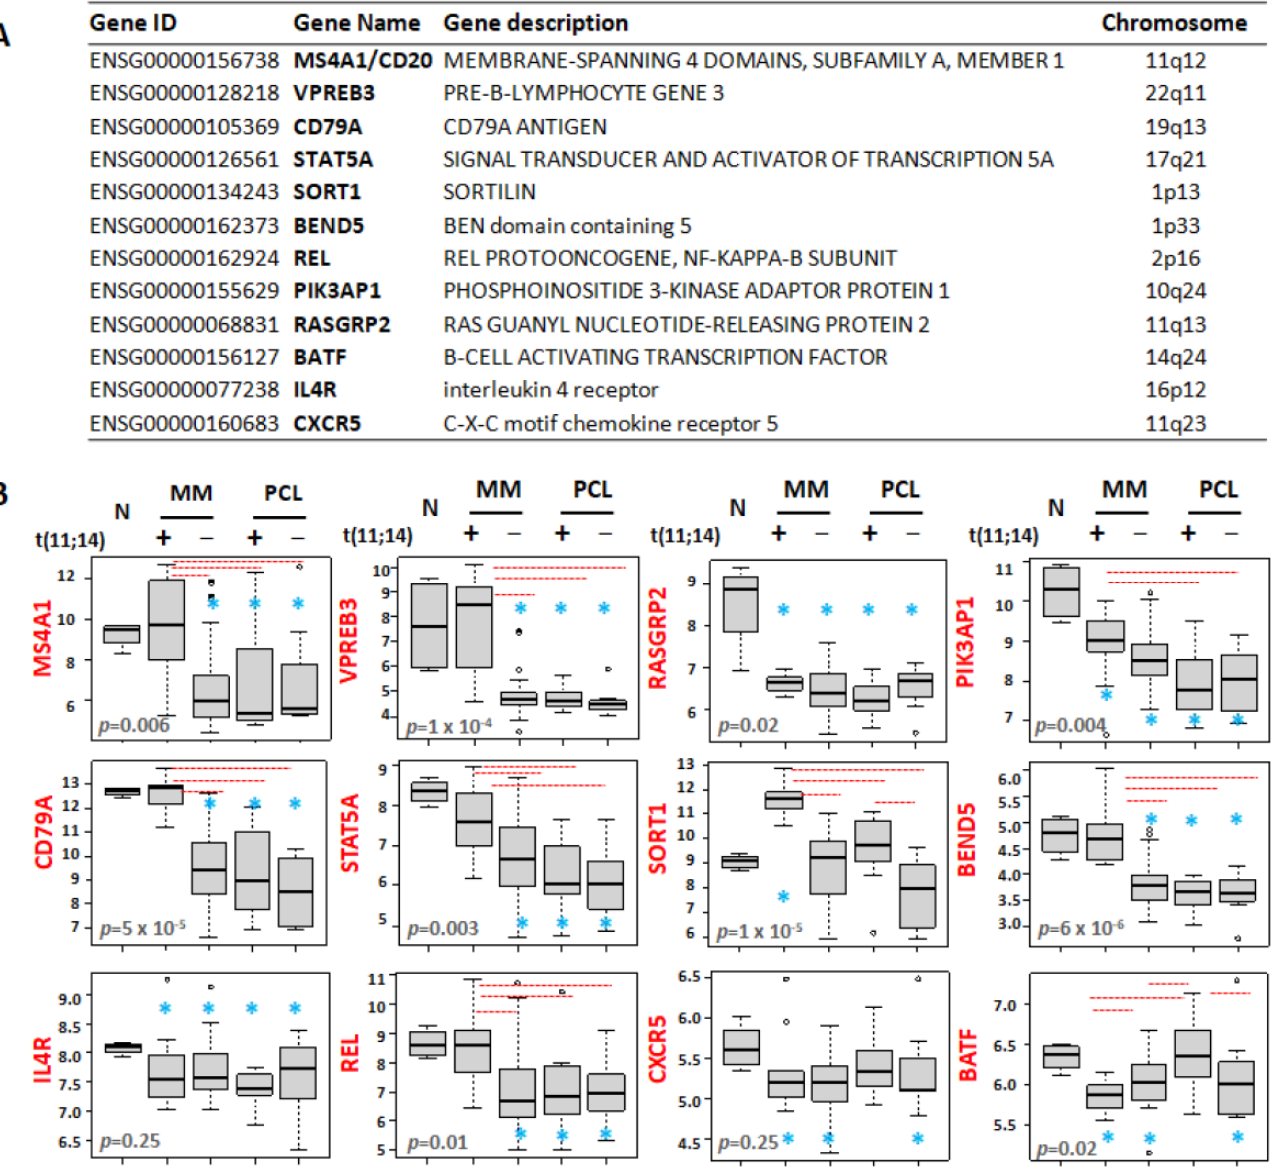
Figure 4. ( A ) Summary information on the 12 B-cell-related genes (Figure 4 in Gupta et al. [19]). ( B ) Box plot representation of the expression of B-cell genes from the signature of venetoclax sensitive MM, in 4 normal controls (N), 12 MM patients carrying t(11;14), 38 MMs without t(11;14), 7 pPCL patients carrying t(11;14), and 8 pPCLs without t(11;14) evaluated by GeneChip ® Human Gene 2.0 ST array (GSE116294). In each panel, red dashed lines below/above two groups indicate significant differences in their gene-expression level; blue asterisks indicate significant differences between the indicated group and N (Dunn’s test p -values are reported in Figure S5). BH adjusted Kruskal–Wallis test p -value is reported for each panel.